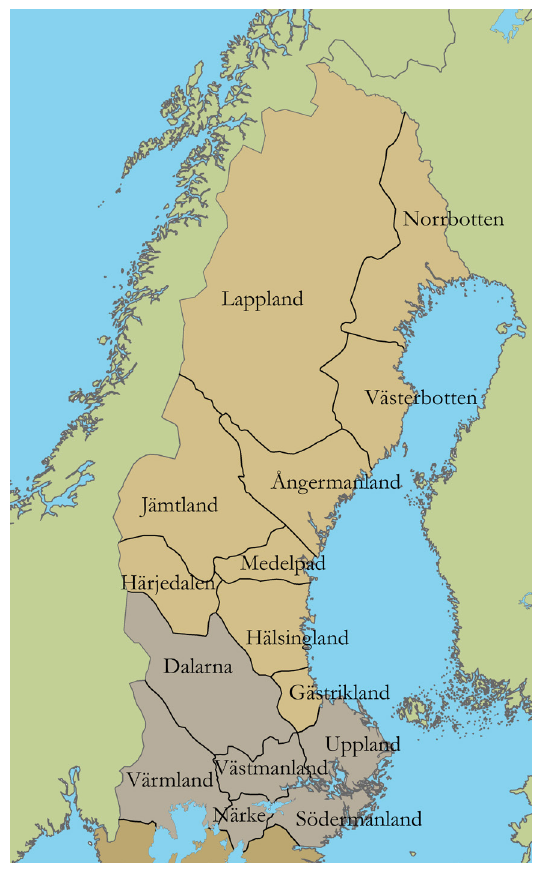
Figure 2: Map showing the provinces of northern and central Sweden. The lighter (brown) areas are northern Sweden or Norr- land, the darker (gray) areas are middle Sweden or Svealand. Map by